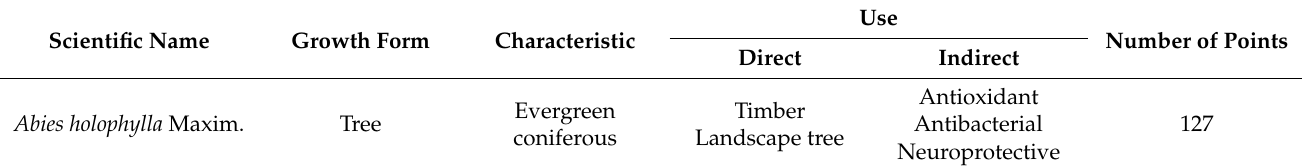
Table 1. The information of the species used for